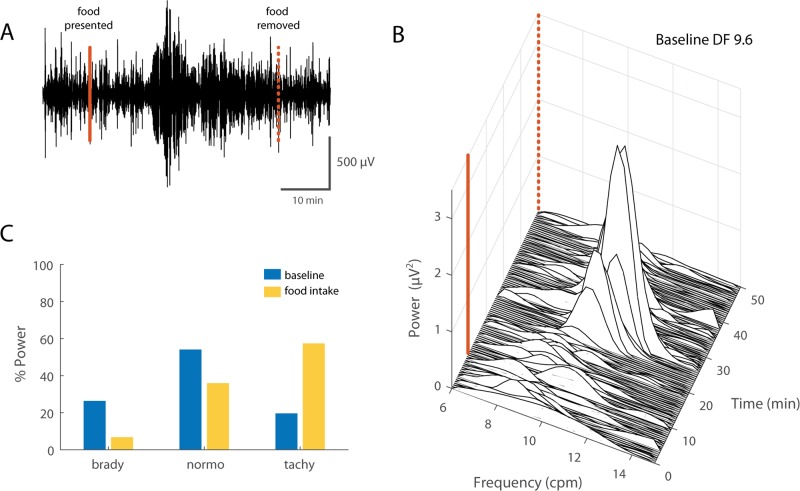
Gastric myoelectric activity during food consumption.A) Example of a 60 min filtered and downsampled GI myoelectric recorded from segment 4 of an awake behaving ferret during a feeding trial. Solid and dashed red lines denote when food was presented and withdrawn. B) Waterfall plot of the power spectral density for the waveform shown in A. Each time window corresponds to the FFT of 1 min of GI myoelectric data. C) Percentage of total power in the 6–15 cpm range partitioned by bradygastric (6.6–8.6 cpm), normogastric (8.6–10.6 cpm) and tachygastric (10.6–12.6 cpm) ranges for a signal with a DF of 9.6 cpm at baseline versus during food presentation and consumption.